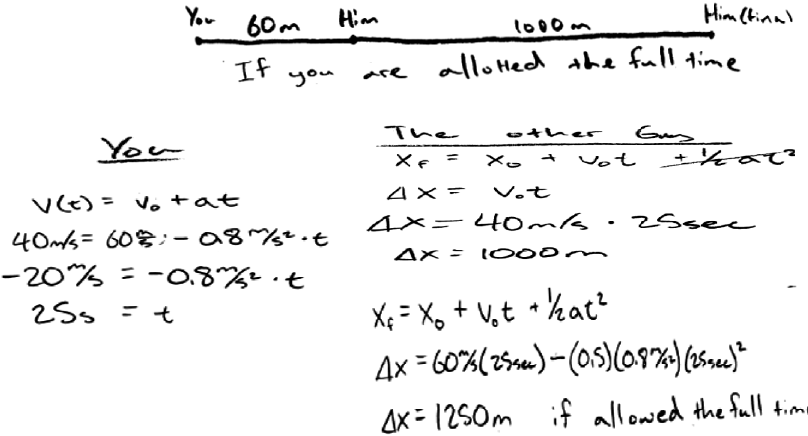
FIG. 9. Inclusion of a diagram which was ignored when dealing with equations.